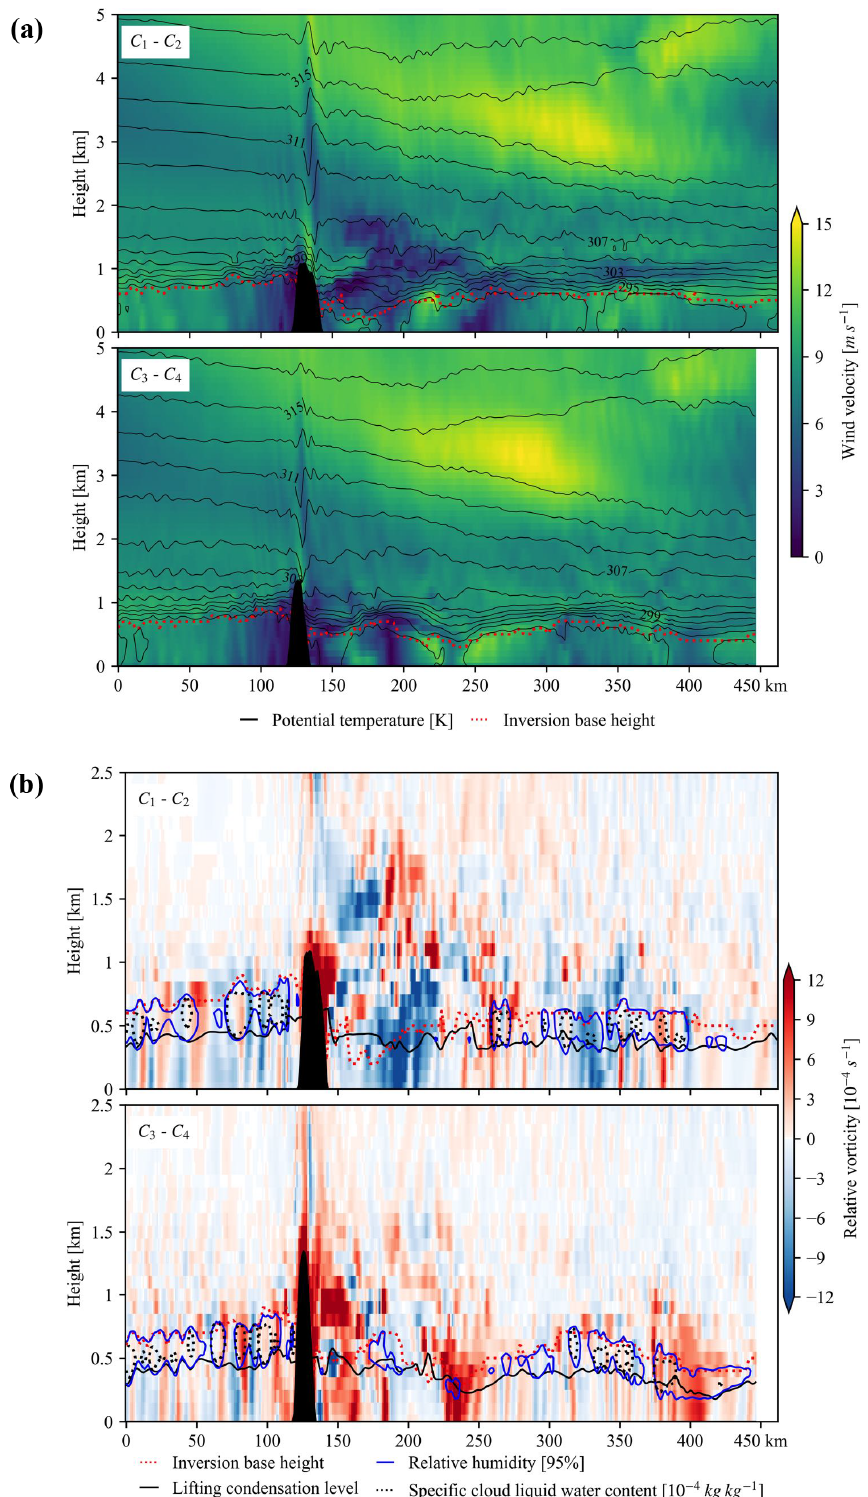
Figure 12. Vertical structure of (a) wind velocity, potential temperature and inversion base height and (b) relative vorticity, relative humidity, lifting condensation level and specific cloud liquid water content along cross-sections C 1 – C 2 and C 3 – C 4 shown in Fig. 11a on 6 August 2010 at